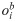
Comparison between experimental data and synthetic observations.Size distribution (A, B and C) and light scattering intensity (D, E and F) as a function of time, at O1 concentration ρ = 1, 3 and 7μM, have been fitted (blacksolid lines in A, B and C, solid red line in D, E and F) using best-fit parameters reported in Table 1. The experimental data are represented in dots black of the same colour as the simulation in A, B and C, in black in (D, E and F). Simulation corresponding to the evolution of size distribution of oib (G) and oia (H) and the sum oia+oib (I).